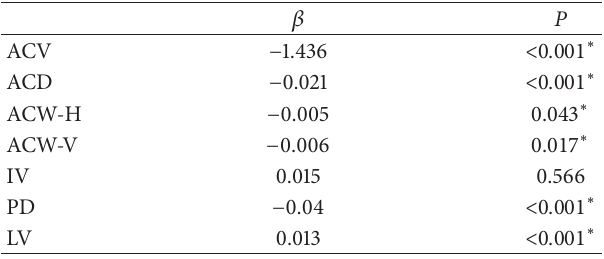
Table 4: Associations between ocular parameters and